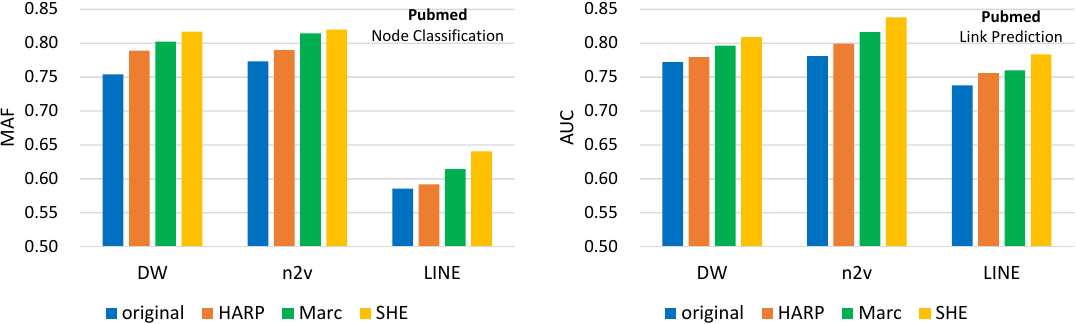
Figure 5. Performance comparison on Pubmed data. Left: node classification by MAF scores. Right: link prediction by AUC scores. Compared methods include the combinations of node embedding methods DeepWalk (DW), node2vec (n2v), and LINE with hierarchical NRL methods: original (original NRL method), HARP, Marc, and our proposed